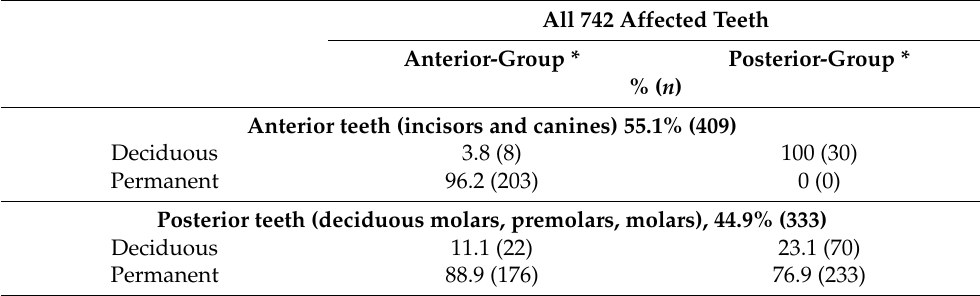
Table 2. Affected MIH Teeth in the Anterior- and Posterior-Group.